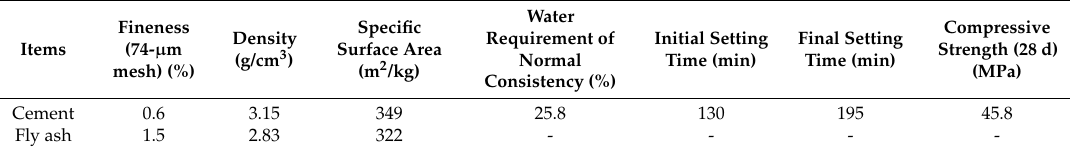
Table 1. Physical properties of cement and fly